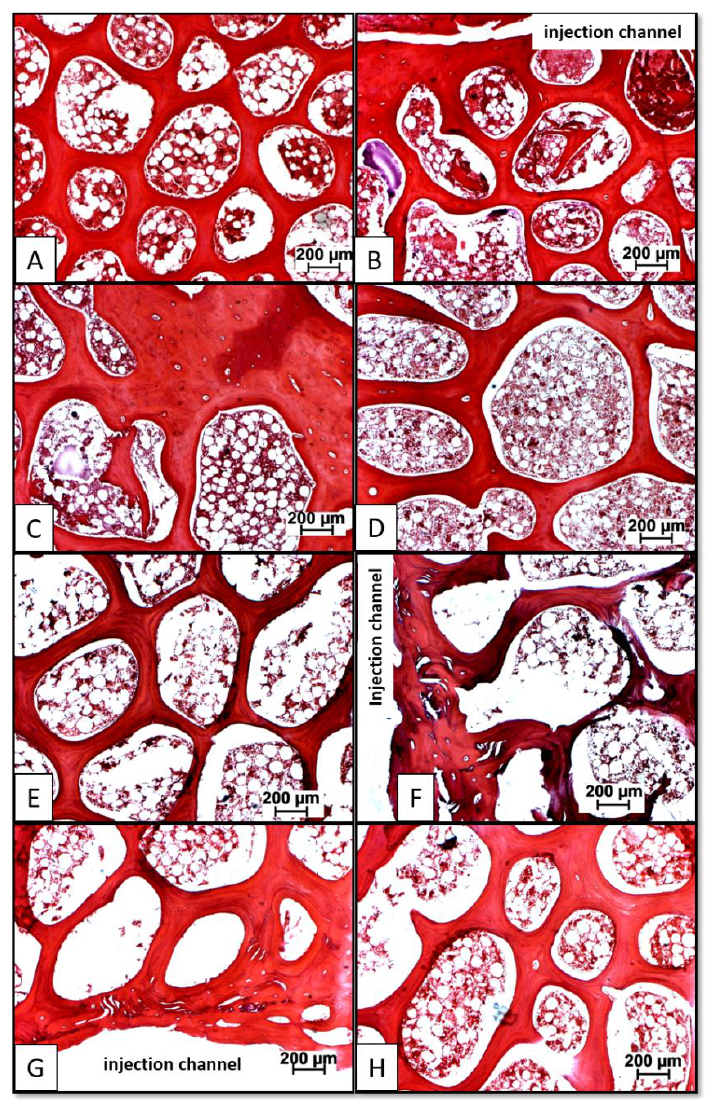
Figure 5. Paraffin sections of lumbar vertebral bodies from long-term animals (9 months) injected with either 10 µg BMP-2 (high dose; ( A – D )) or with 5 µg GDF-5 (low dose; ( E – H ); for a low magnification overview of the injection channel in the vertebral body please compare with Figure 4). Hematoxylin-eosin stain, staining bone trabeculae including newly formed bone with embedded osteocytes in red and bone marrow including hematopoietic cells and fat marrow in purple/white; ( A ) control (L3); ( B ) HA-injected vertebral body (L5; injection channel); ( C ) HA/BMP-2-injected vertebral body (L4; injection channel); ( D ) HA/BMP-2-injected vertebral body (L4; remote area); ( E ) control (L3); ( F ) HA-injected vertebral body (L5; injection channel); ( G ) HA/GDF-5-injected vertebral body (L4; injection channel); ( H ) HA/GDF-5-injected vertebral body (L4; remote area).